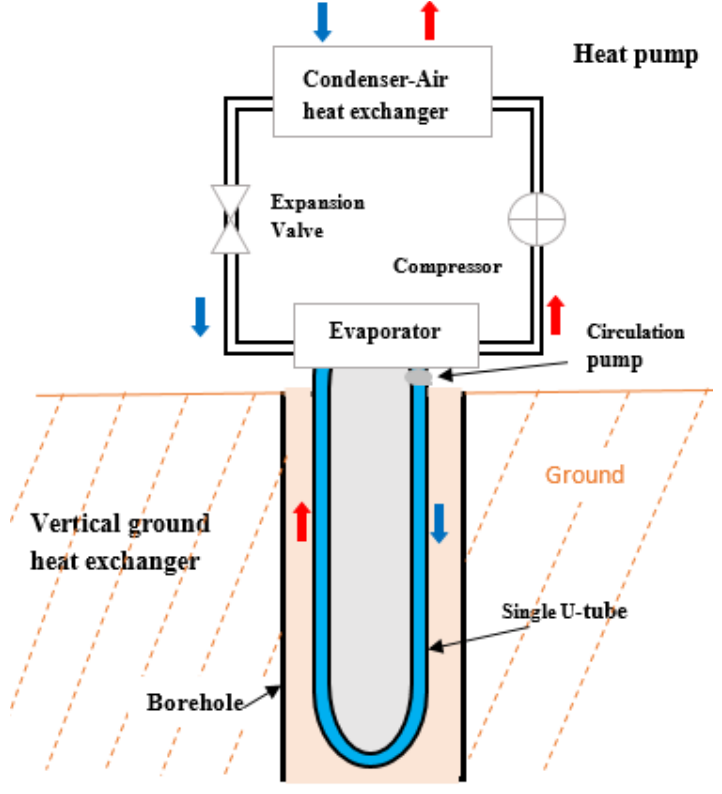
Figure 1. Ground source heat pump system (in heating-dominated climate).